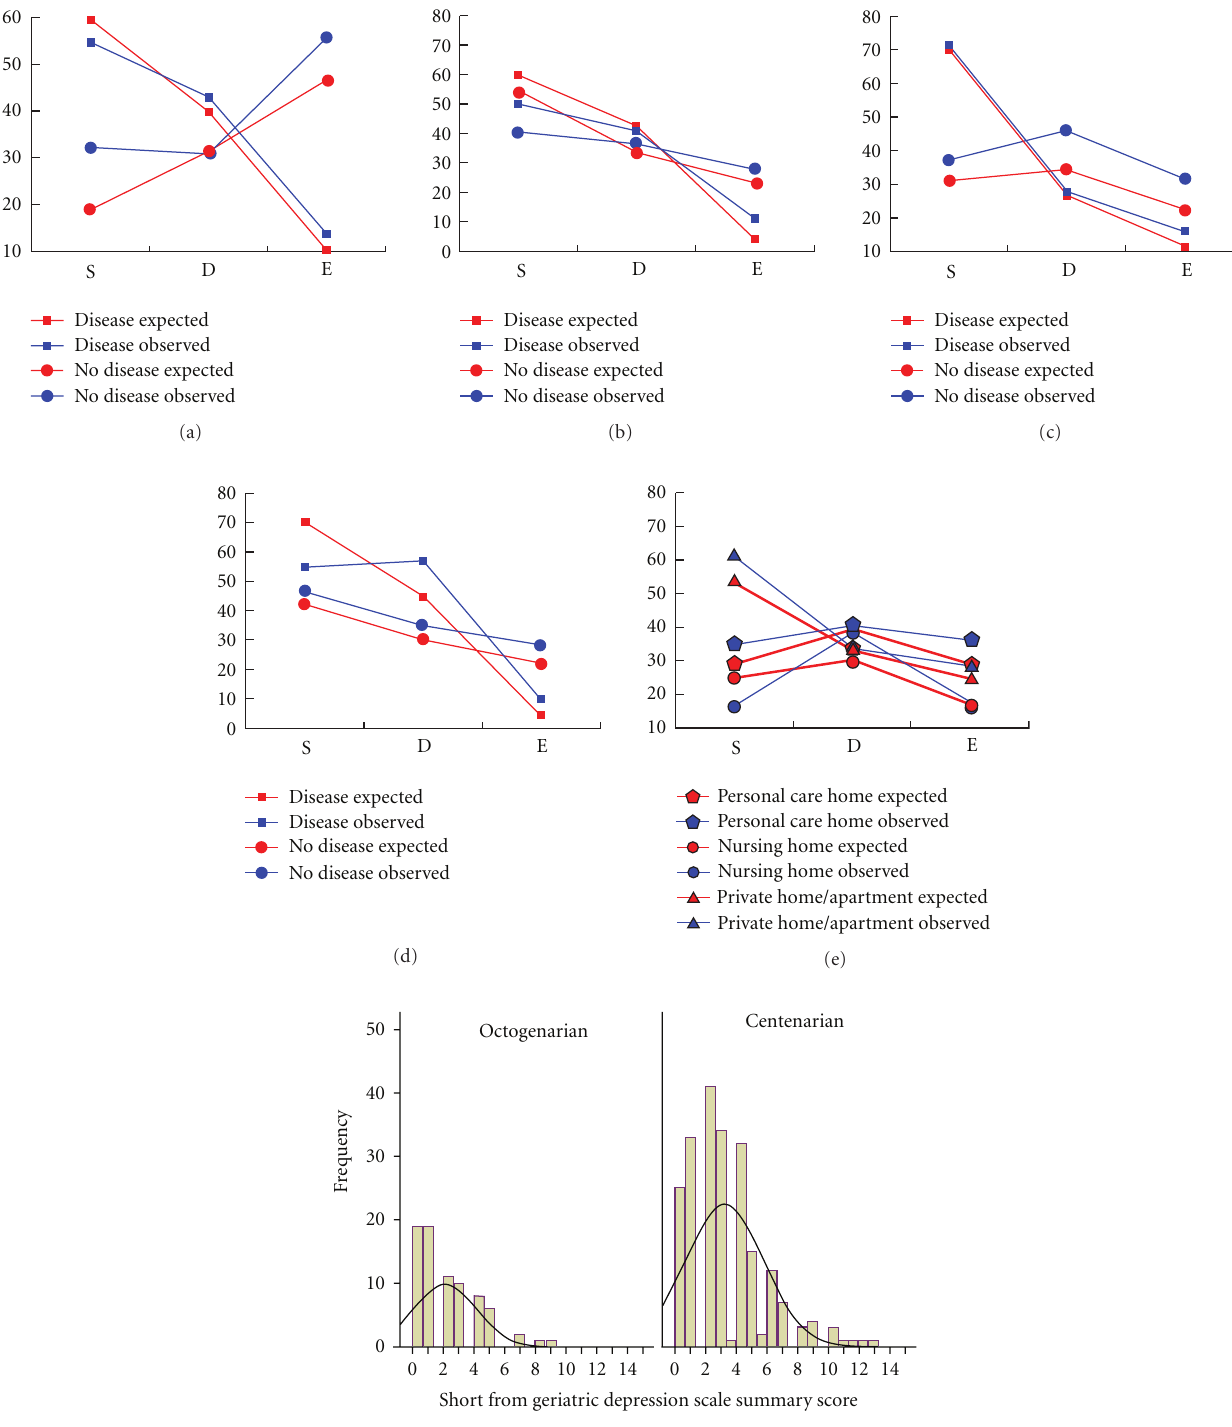
Figure 2: The factors of cardiovascular disease (a), cancer (b), pneumonia (c), psychiatric disorders (d), and living arrangement (e) determine the fraction of survivors, delayers, and escapers [4] among centenarians. The observed (in blue) and expected proportions (in red) track each other in that the logistic multinomial model well predicts the outcome of a being a survivor (S), delayer (D), or escaper (E) [4]. In panels (a)–(e), a square indicates the presence of a disease and a circle, the absence of a disease. (f). Centenarians were higher (with mean of 3.21 and standard deviation of 2.56) on the Geriatric Depression Scale (GDS) [6] than the control group of octogenarians (with mean of 2.13 and standard deviation of 2.62). The proportion (15.5%) of centenarians with GDS from 6–15 is significantly di ff erent from that proportion (4.6%) in octogenarians ( Z = 3 . 13, P < .